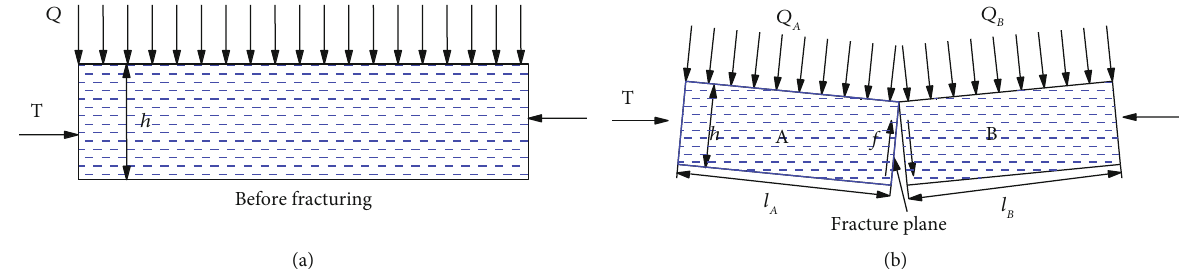
Figure 6: The stress analysis of cutting block in fracturing horizon: (a) before fracturing and (b) after fracturing.